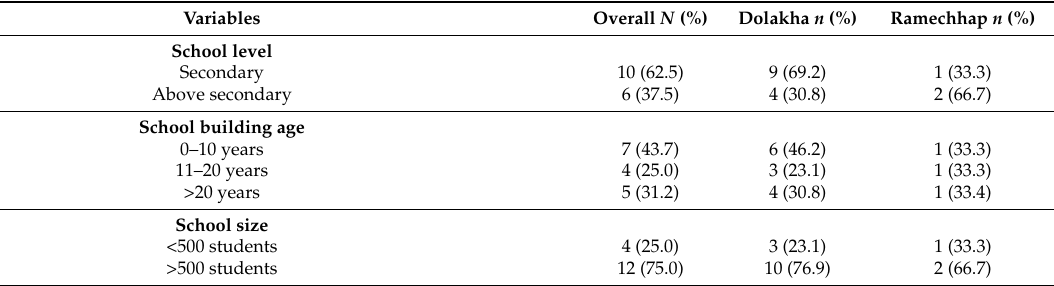
Table 2. School characteristics and WASH (water quality, sanitation, and hygiene) conditions in Dolakha and Ramechhap districts, Nepal, March–May